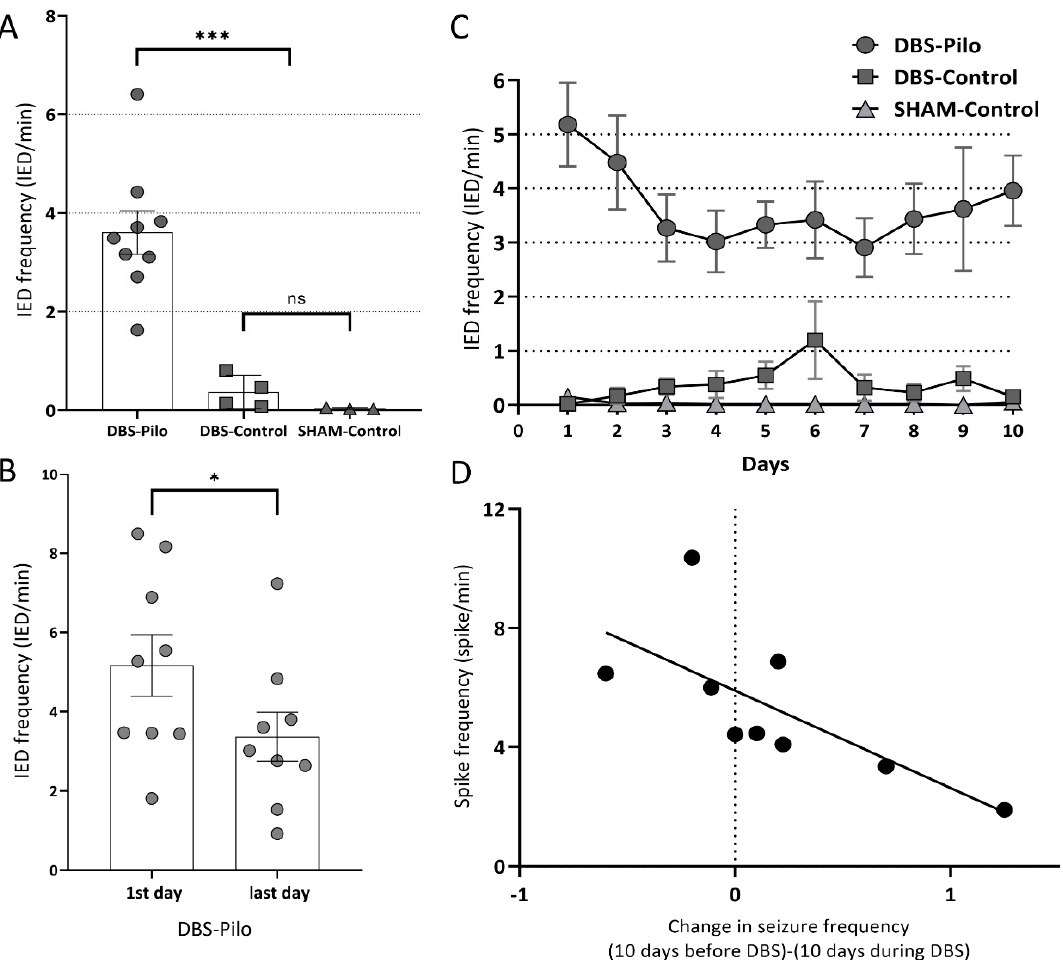
Figure 3. Interictal discharges. ( A ) IED (interictal epileptiform discharge) frequency in different animal groups (dots: individual values, box, and whisker: mean ± SEM). The average IED of DBS-Pilo animals was compared to the controls (*** p < 0.001, ns = non-significant). When the two control populations were compared there was no significant difference between them. ( B ) IED frequency of DBS-Pilo animals on the first and the last day of stimulation (dots, box, and whisker as in panel A, * p < 0.05). 7 out of the 9 animals showed a decrease. ( C ) IED frequencies during the 10 days of deep brain stimulation. Dots represent the average IED rate on a given day in the given group. A decrease is observed in the pilocarpine group in the first couple of days, with a slight increase in the last days. On the 6th day, the control group had an increase in IED numbers, but this was not permanent. ( D ) Correlation between average spike rate and change in seizure rate of individual animals. There was a significant correlation (r = − 0.71, p < 0.05). Positive values on the horizontal axis indicate a decrease in seizure frequency while negative values increase. The IED frequency decreased in the DBS-Pilo group during the 10 days of stimulation: on the 10th day, the IED rate was significantly lower by 34.8% compared to the first day (5.17 ± 0.77 vs. 3.37 ± 0.62 IED/min) (Figure 3B). The most evident decrease in the IED rate in the DBS-Pilo group is observed during the first 3 days of DBS, with a slight increase in the last days (Figure 3C). The reduction in seizure rate (the difference between the seizure rate during the 10 days of DBS compared to 10 days before DBS) had a negative correlation with the average IED rate. Subtype analysis of IEDs had shown a negative correlation with spike rate and polyspike rate in individual animals (r = − 0.71, p < 0.05 and r = − 0.69, p < 0.05) (Figure 3D). However, there was no correlation between the rate of reduction in seizure numbers and sharp waves. Each animal had more IEDs on one side (left or right hippocampus). The side distribution was not systematic, i.e., there were animals with more IEDs on